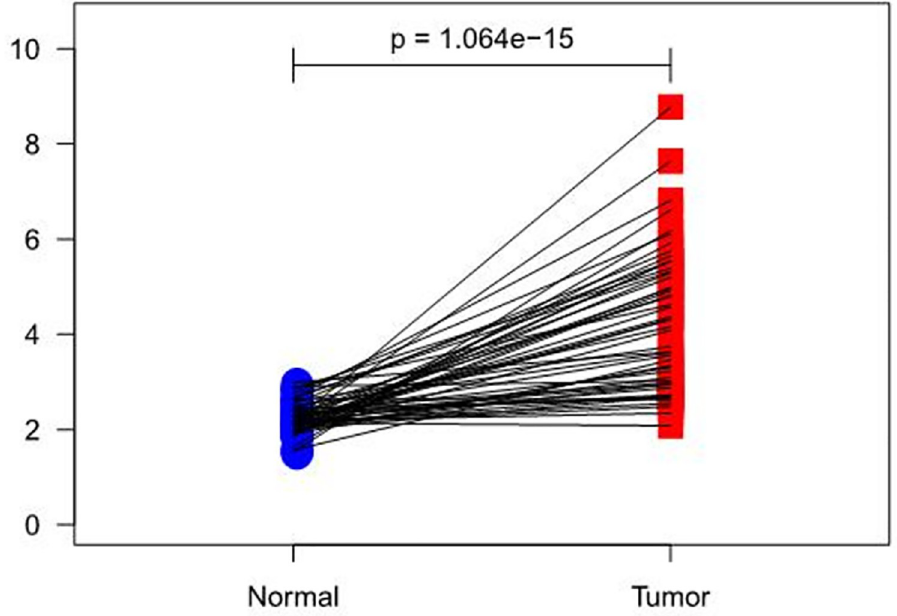
Fig 1. A paired scatter plot of RIOX2 gene differential expression in lung adenocarcinoma between cancerous tissues and adjacent normal tissues. The abscissa represents the sample group and the ordinate represents the RIOX2 gene expression level. The red represents the cancer tissue sample group and the blue represents the normal sample